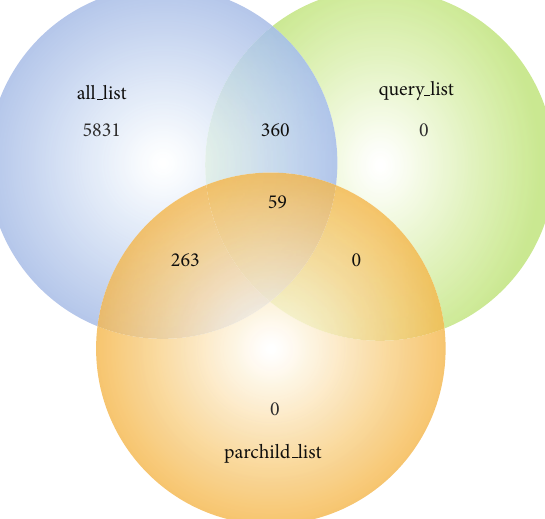
Figure 2: Venn diagram displaying overlapping terms across the three GOLink terms lists generated using the query term “regulation of gene expression” (GO:0010468) and applying the evidence code filter “!IEA” and database filter “UniProtKB.” The all list, query list, and parchild list returned 6513, 419, and 322 terms,